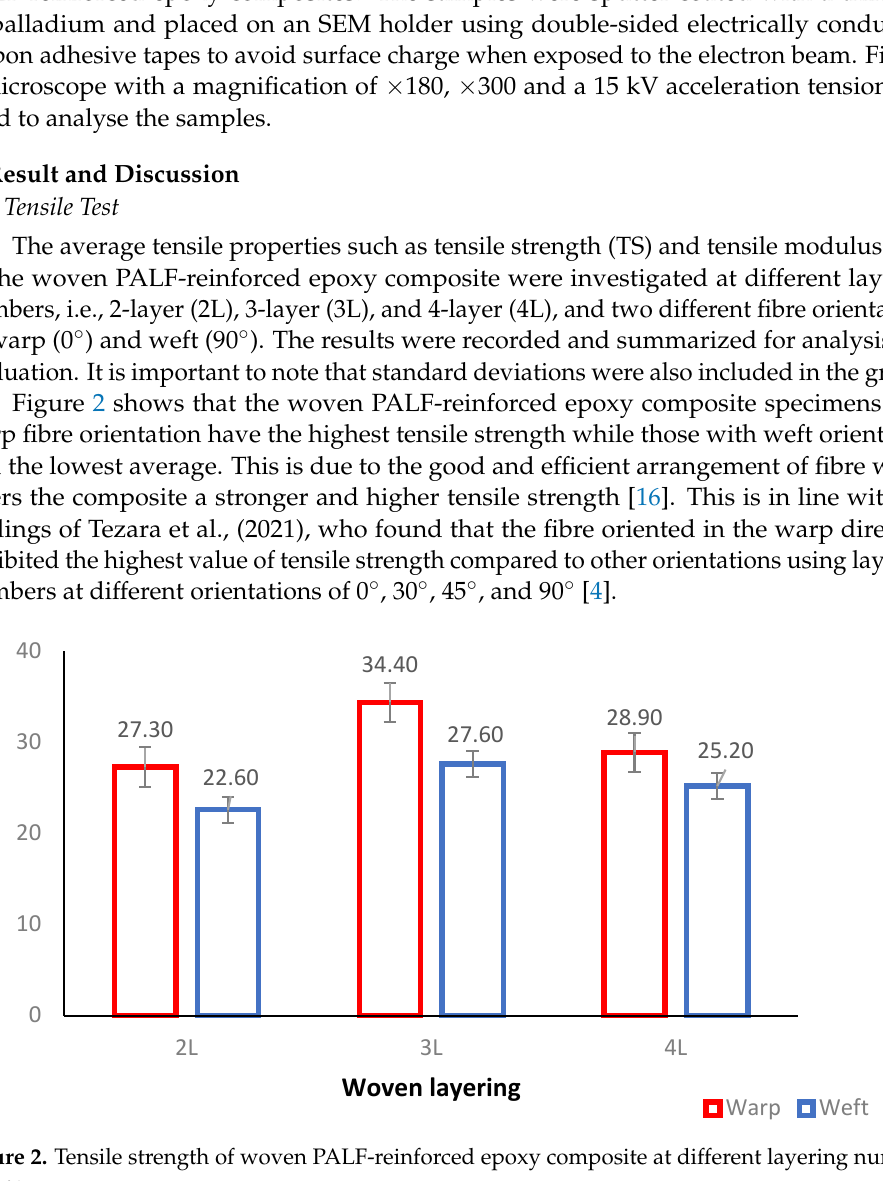
Figure 2. Tensile strength of woven PALF-reinforced epoxy composite at different layering numbers and fibre